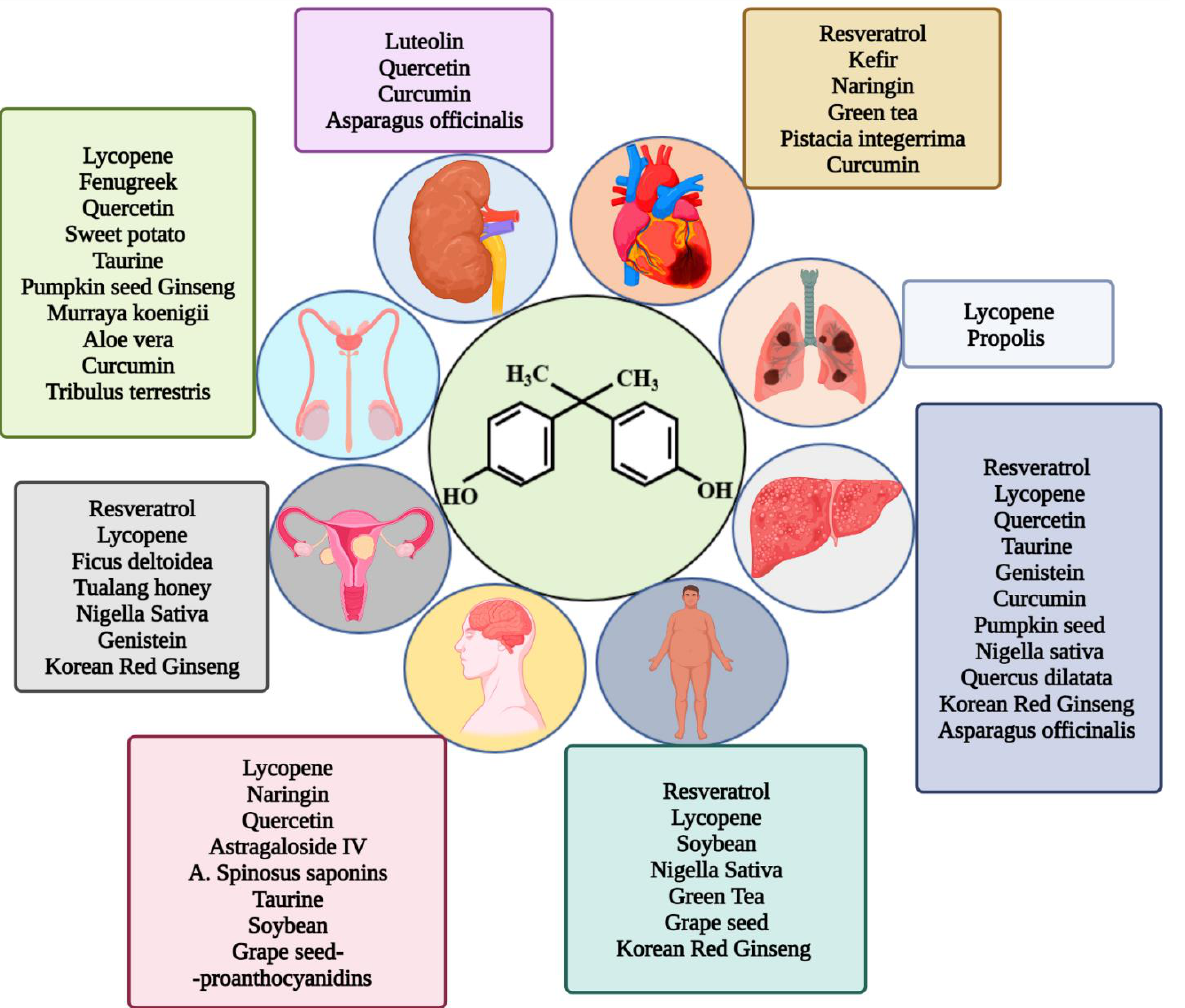
Figure 4. Schematic diagram showing the various NPs evaluated for their potential ameliorating roles against specific BPA-induced toxicity.